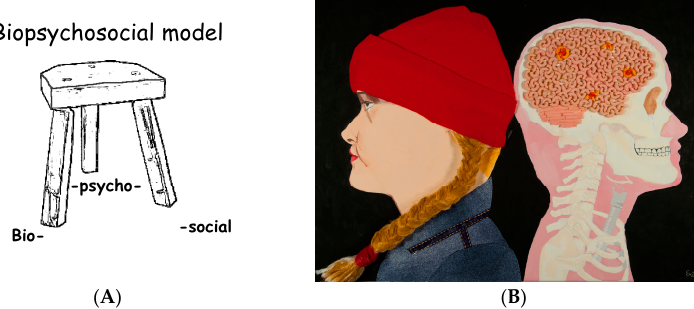
Figure 1. ( A ) Biopsychosocial model—the example of a three ‐ legged stool is often used to discuss this topic with the participants, focusing on the concept that all three legs are needed to be able to sit on the stool; ( B ) this image, created by a student of the Pain 101 course entitled “Untitled”, is often used to assist in the explanation of the biopsychosocial model, in order to explain pain locations in the